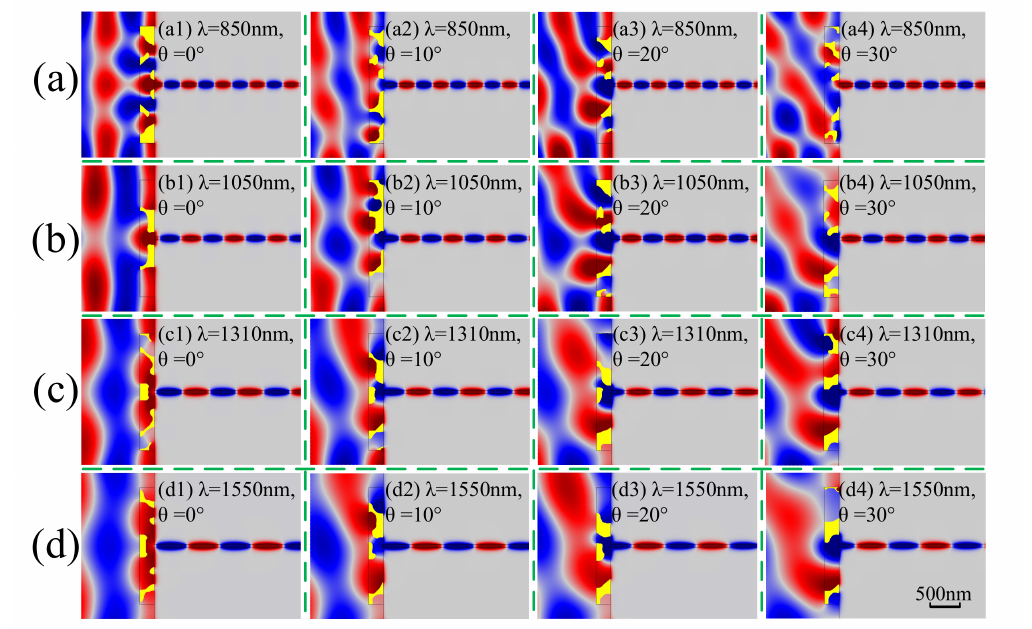
Figure A5. Inversely designed nanoantennas for the oblique angles 0 ◦ , 10 ◦ , 20 ◦ , and 30 ◦ , and the four communication wavelengths.